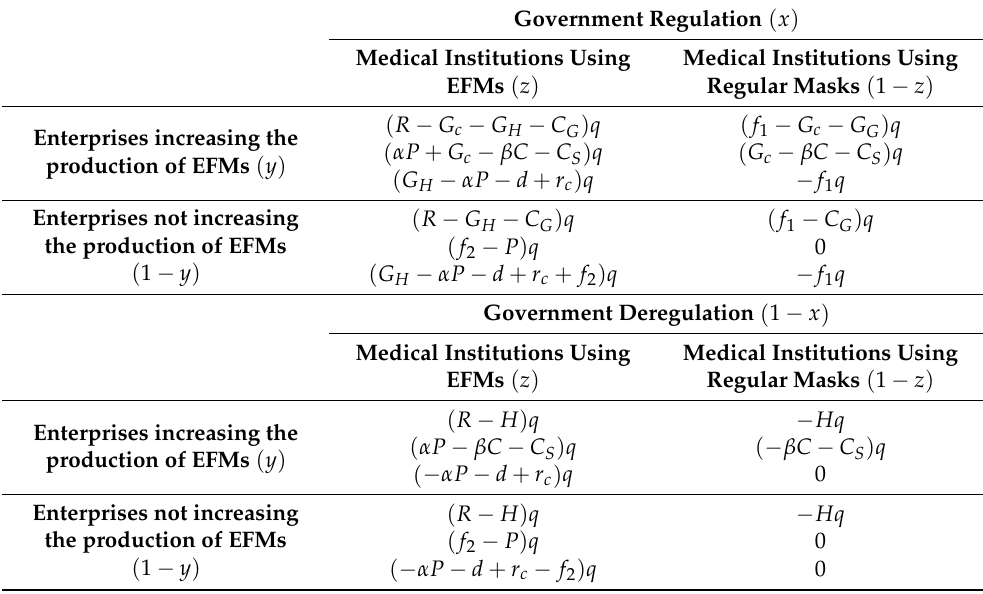
Table 2. Evolutionary game payoff